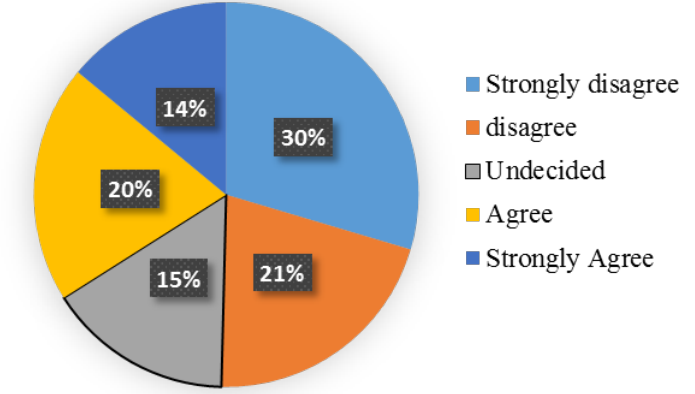
Figure - 8: Showing online learning decreased the value of traditional teaching and learning